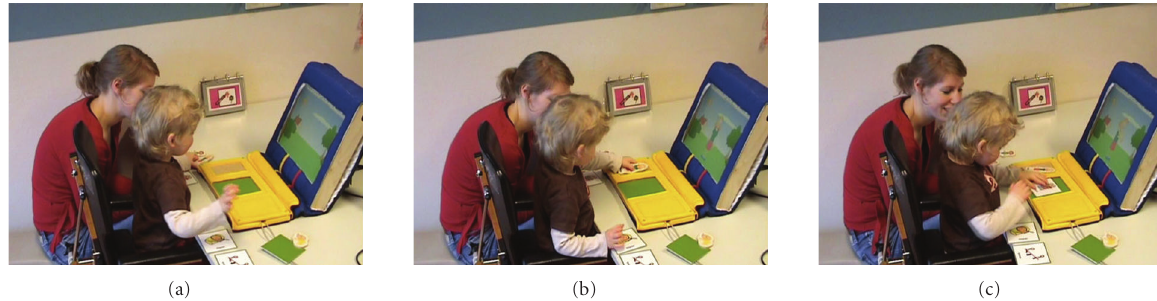
Figure 6: The combination exercise. From left to right: (a) the wooden piece of “the woman” is selected, (b) placed on the wooden “subject” area, and (c) combined with the PCS verb-card “cuddle” into the sentence “the woman cuddles.” three Dutch word lists, N-CDI [39], the Lexilijst [40], and the list Duizend-en-een-woorden [41]. In each scene, up to three PCSs were shown to emphasize the core words in the